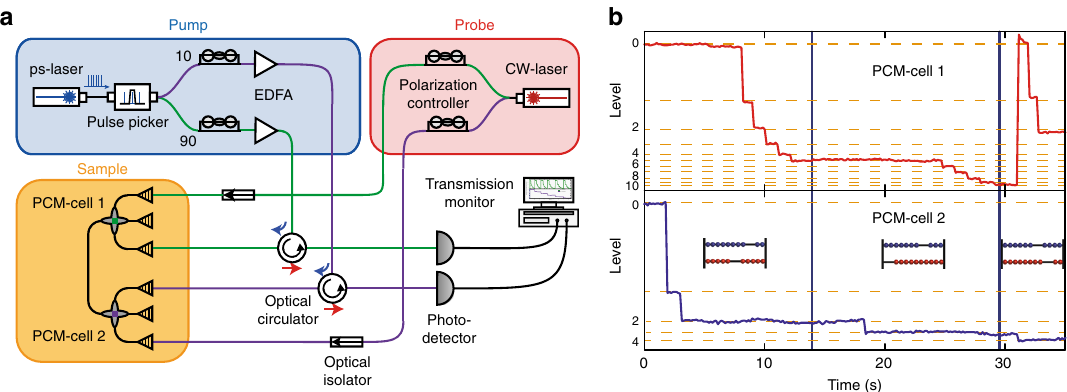
Fig. 3 Two-digit arithmetic with carryover. a Pump-probe set-up using two separate phase-change cells. The pump pulse to switch ‘ PCM-cell 1 ’ is split (90:10) and partially sent to the second PCM-cell. When a high energy reset pulse is sent to the fi rst cell in order to perform the carryover, the energy of the pulse guided to the second cell is enough to induce a crystallization step in the second cell. b Calculation of ʻ 74 − 17 = 57 ’ using two PCM-cells and the nine ’ s complement method for subtraction, which is equal to the addition ʻ 25 + 17 = 42